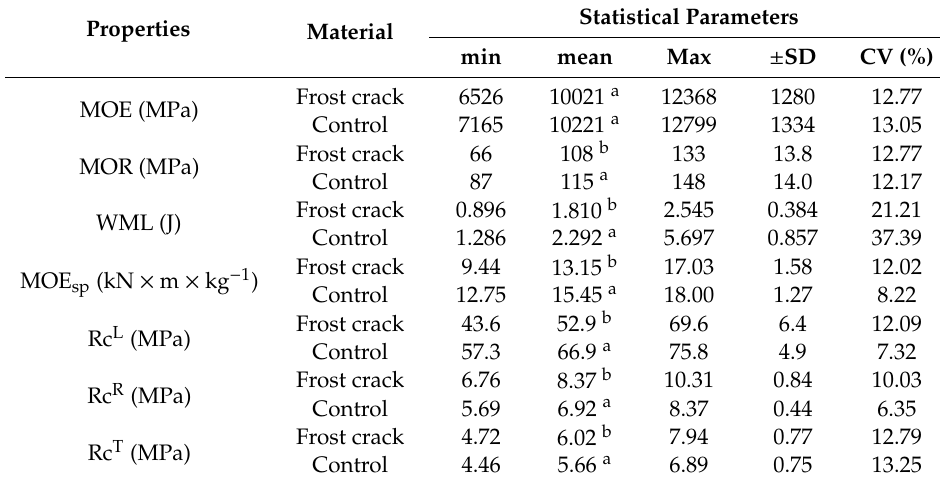
Table 4. Basic statistical parameters of mechanical properties of oak